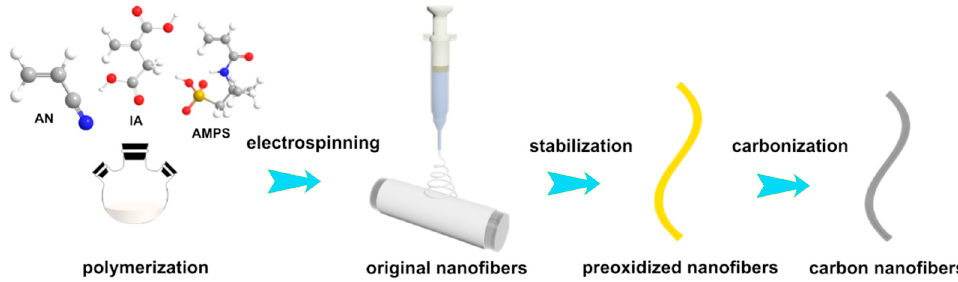
Scheme 2. Schematic illustration of the processes of polymerization, electrospinning, stabilization, and carbonization.